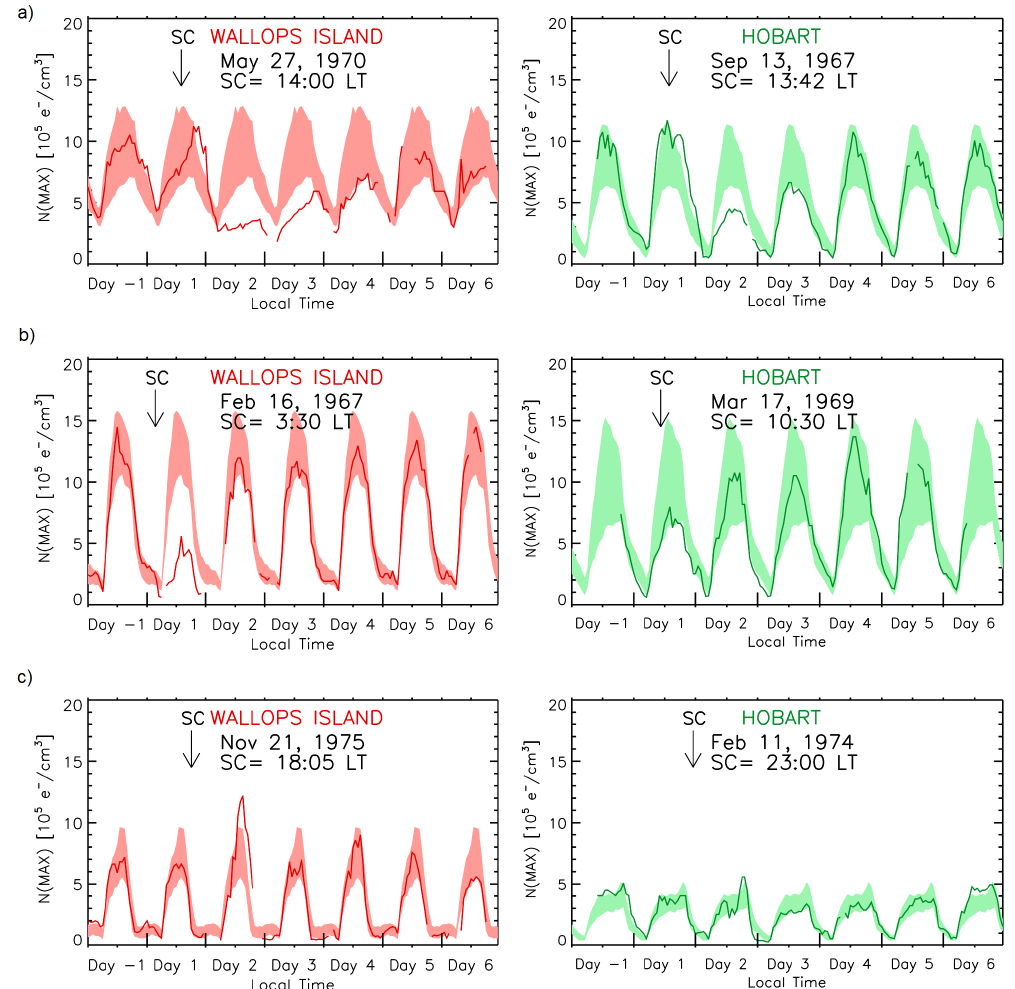
Fig. 2. Examples of the three types of ionospheric storms that occur when following the local time developments of Nm F2 during geomagnetic storms with SCs during different portions of the day. The patterns are characterized by the occurrence (or lack of occurrence) of the afternoon enhancement (“dusk effect”) component of the positive phase (assigned as Day 1 of the storm period). In panel (a) , events when the SC occurs during daytime hours at both stations lead to a ‘regular positive phase” (RPP) pattern. In panel (b) , when SCs occur pre-sunrise or early in the day, the ionospheric response is to exhibit only a negative phase, and these are called “no positive phase” (NPP) storms. For averaging purposes, they are shifted 24-h to coincide with Day 2. In panel (c) , storms that occur in the post-sunset period or very early in the day, but exhibit a dusk effect positive phase on the subsequent afternoon, these are treated as delayed-positive-phase (DPP) storms and they are shifted back 24h in time so their dusk effects occur on Day 1. These adjustments to placement within LT averaging bins enhance the resultant patterns. See also Figs. 3 and 4 where the RPP events occur 124 times at Wallops and 127 times at Hobart; the NPP events number 53 at Wallops Island and 70 at Hobart; The DPP events occur 29 times at Wallops Island and 9 times at Hobart. The same magnitude scale for Nm F2 is used in all panels to emphasize the strong pre-storm seasonal and solar cycle effects at the times of the